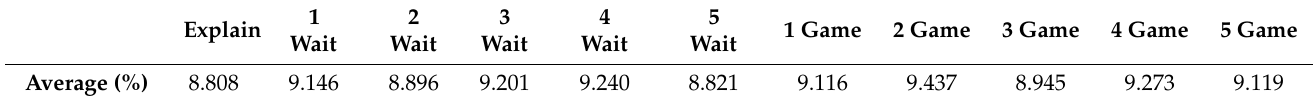
Table 4. Average attention score for each stage of all children obtained through the channel atten- tion layer.